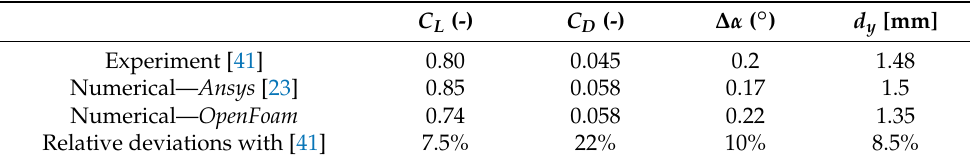
Table 3. Numerical and experimental hydrodynamic coefficients C L et C D , angle of attack deviation ∆ α , and maximal strain d y for a 3D deformable cantilevered NACA0015. The relative deviations are based on the numerical